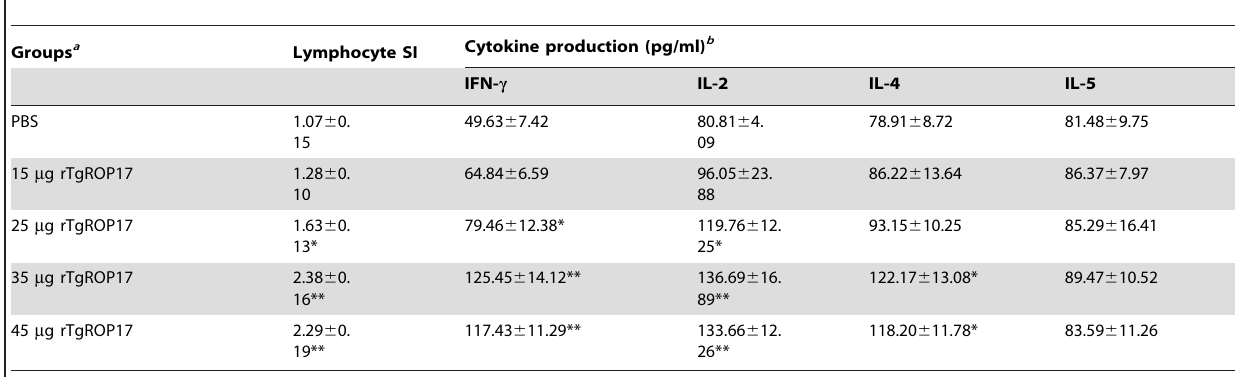
Table 1. Lymphocyte proliferation and cytokine production by splenocytes stimulated with rTgROP17.